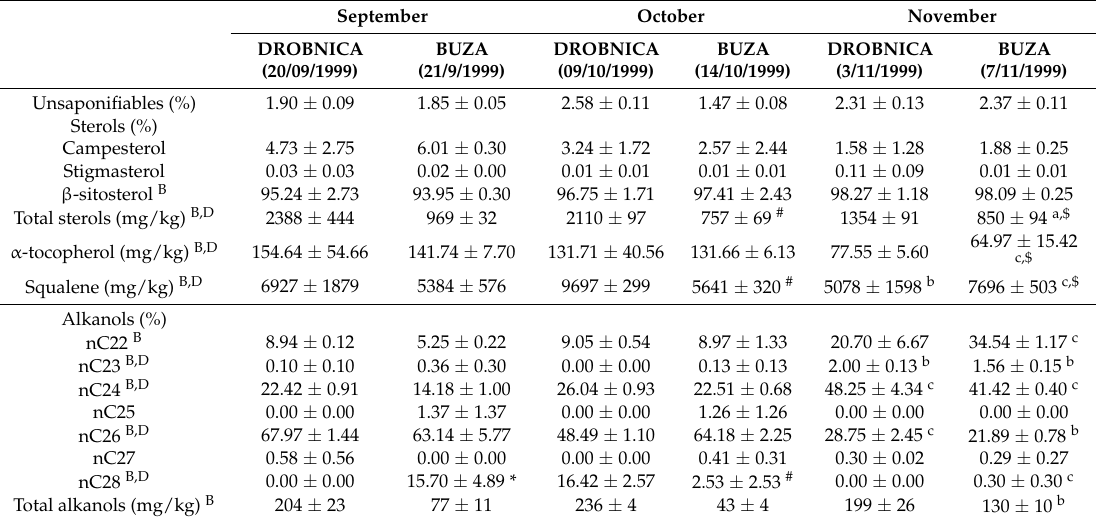
Table 3. Composition of unsaponifiables at various stages of Drobnica and Buza